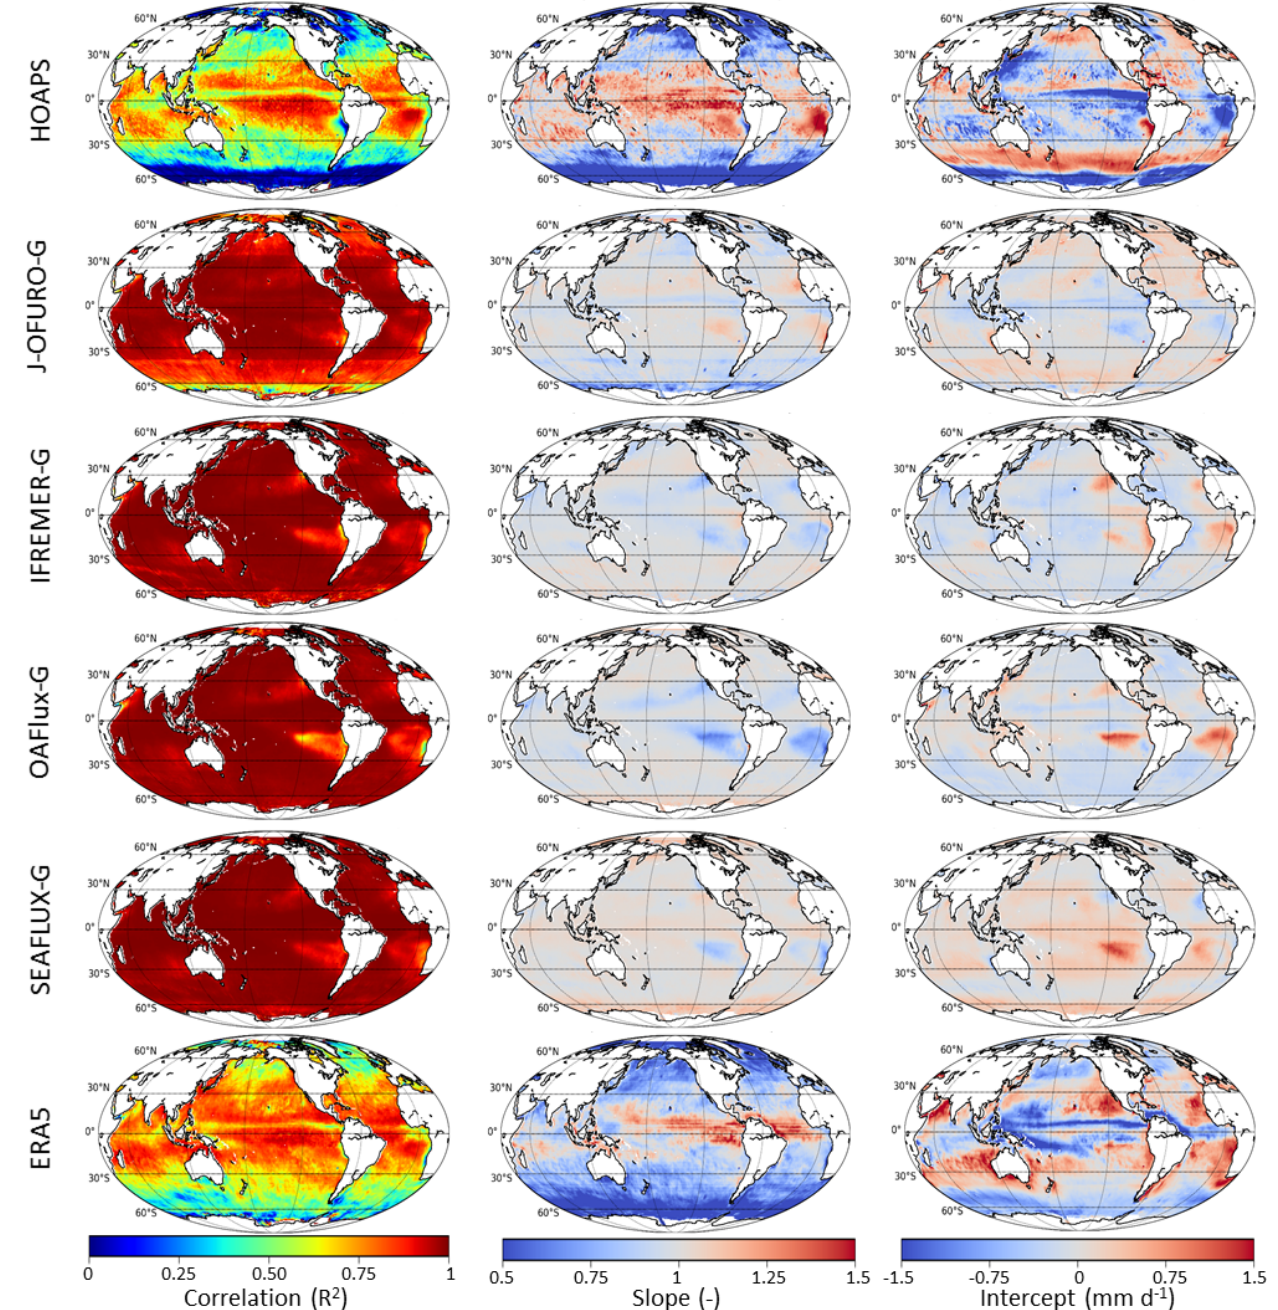
Figure 6. Correlation, slope, and intercept of the linear regression of monthly mean E − P from (top to bottom) HOAPS, J-OFURO-G, IFREMER-G, OAFlux-G, SEAFLUX-G, and ERA5 with satellite ensemble median (SEM) monthly mean E − P (1997–2013).